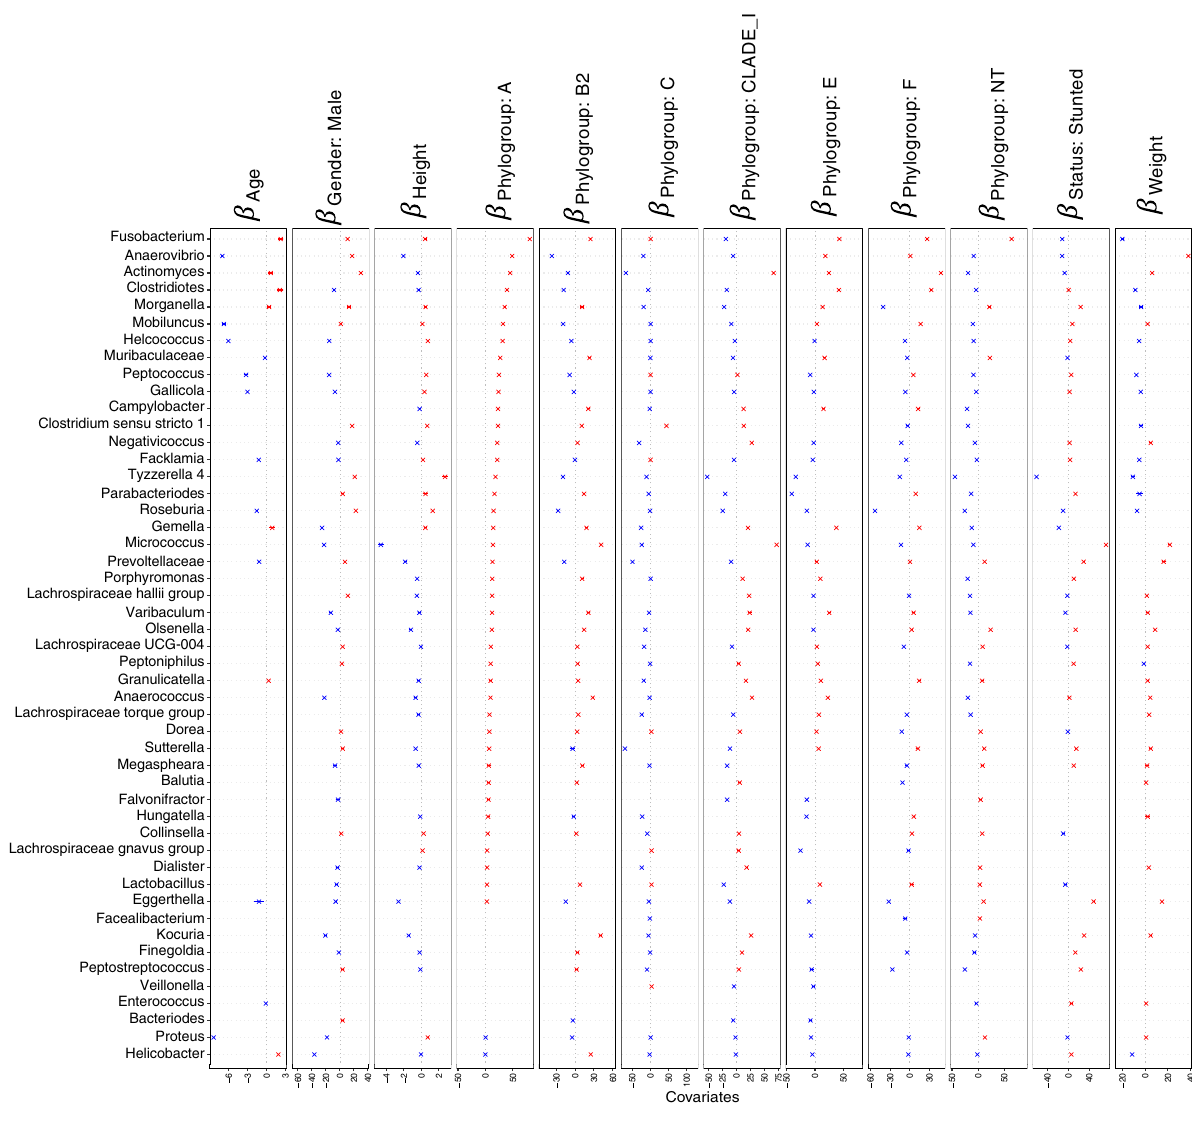
Figure 8. Beta-coefficients returned from the GLLVM procedure for covariates considered in this study by considering top 100 most abundant genera incorporating continuous data (Age, Height, and Weight) as well as categorical labelling of samples (Gender, Male, and Phylogroups). Those coefficients which are positively associated with the microbial abundance of a particular species are represented in red colour whilst those that are negatively associated are represented with blue colour, respectively. Where the 95% confidence interval of the beta-coefficients crosses the 0 boundary, i.e., they are insignificant, are represented by grey colour. Since the collation of the OTUs were done at Genus level, all those OTUs that cannot be categorized based on taxonomy are collated under “Unknown” category. The figure only shows beta-coefficients for 49 genera with the remaining ones shown in Fig.